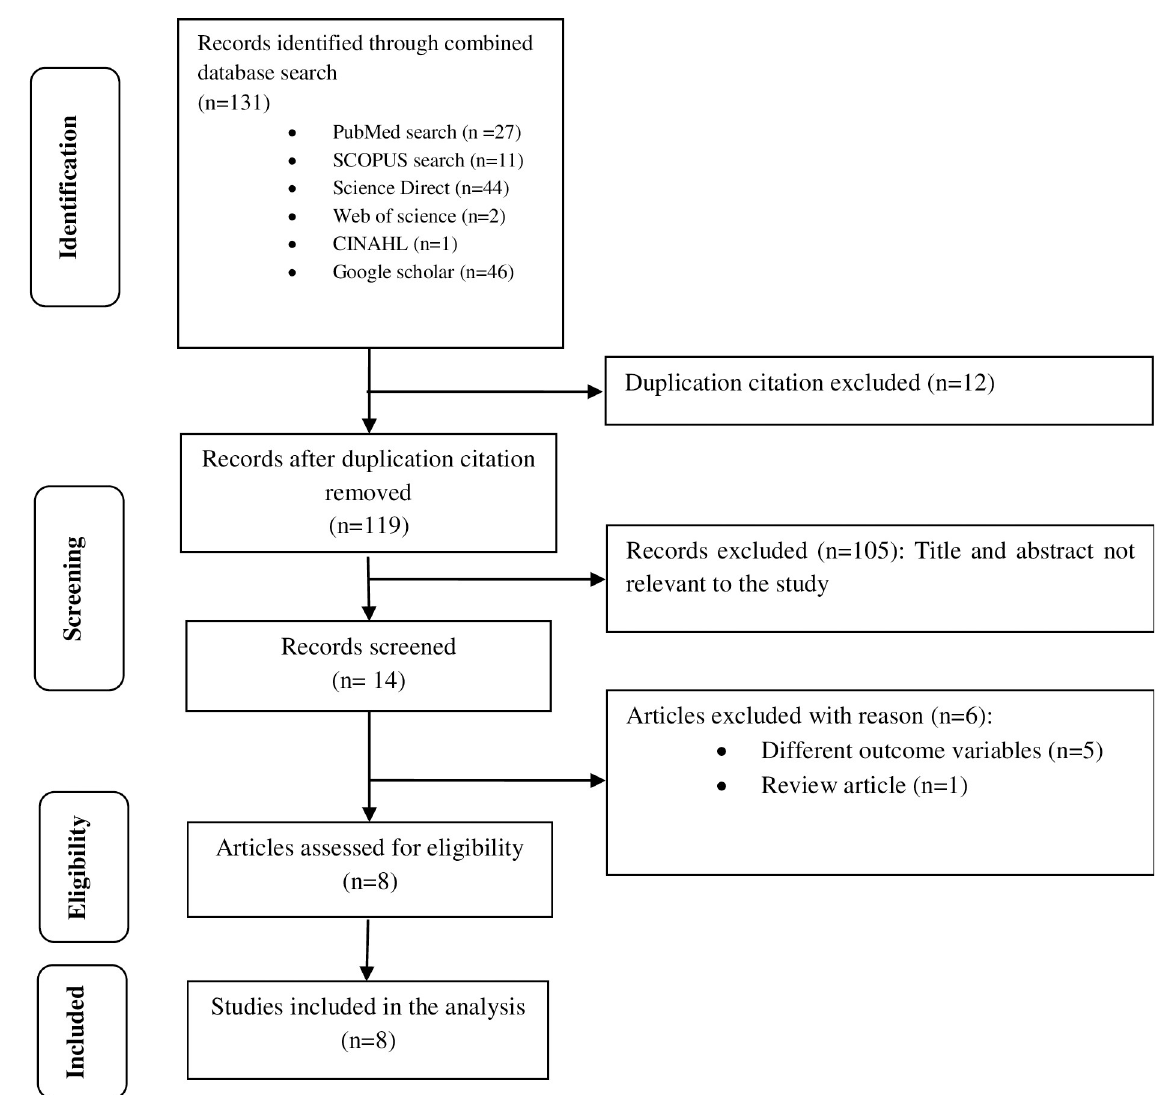
Fig 1. Flow diagram of studies reviewed, screened and